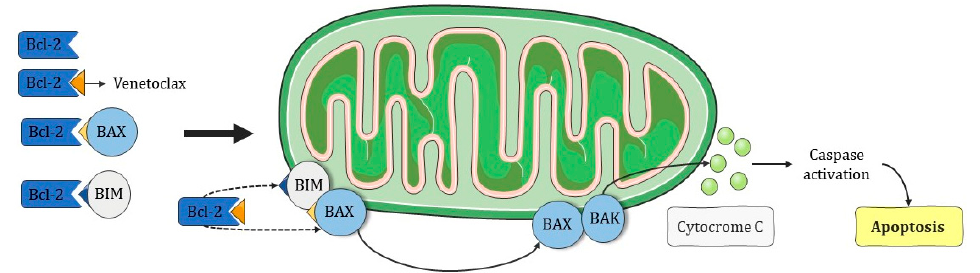
Figure 7. Gilteritinib and Midostaurin mechanism through FLT3 kinase inhibition. BCL-2 associated protein X (BAX) is a pro-apoptotic protein that is recruited by Venetoclax. In the presence of an apoptotic signal, BAX is translocated from the cytoplasm to the vicinity of the mitochondria, where it undergoes activation and conformational modification before adhering to the outer mitochondrial membrane. Small units of activated BAX proteins form oligomers that eventually penetrate the outer mitochondrial membrane and release cytochrome c, which activates the cell cascade to apoptosis via caspases (adapted from Kucukyurt & Eskazan, [37]).